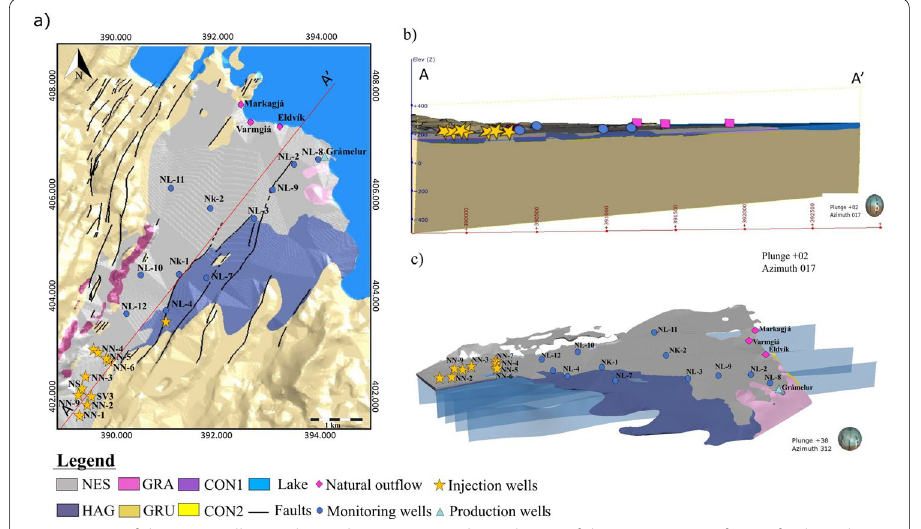
Fig. 2 Map of the Nesjavellir geothermal system. a Geological map of the survey area, after Hafstað et al. (2007). b Cross‑section A–A’ showing major stratigraphic units, Nesjahraun lava flow (NES), Hagavíkurhraun lava flow (HAG), Grámelur cone fragments (GRA) and Grunnberg composite hyaloclastite and lavas (GRU).